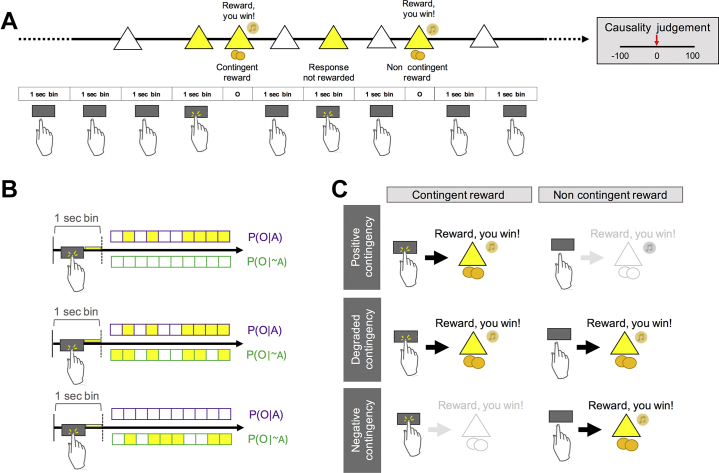
Experimental paradigm. (A) Subjects had to complete an experimental session of 12 blocks of 2 minutes each. At the end of each block, subjects had to judge to what extent pressing the space bar caused the occurrence of the reward, on a scale from −100 (pressing the space bar always prevented reward) to 100 (pressing the space bar always caused reward). During the experimental session, the participant was presented with a white triangle and could decide whether to press the space bar or not. Rewards were delivered contingently on pressing of the space bar or noncontingently in the absence of a response. In addition, a running total of the amount of money earned within a block was continuously displayed in the upper corner of the screen (not shown in figure). In cases where the participant was not pressing the space bar for multiple (hidden) 1-second bins in a row, the white triangle was continuously displayed on the screen, unless a nonresponse contingent reward occurred. In those cases, a reward was displayed on the screen noncontingently. (B) Each block was divided into 120 unsignaled time periods (bins) of 1 second. When a response occurred within each bin, the triangle turned yellow until the bin ended. If a response was recorded during the bin, a contingent reward was delivered at the end of that bin according to the applicable probability of outcome delivery given a response [P(O|A)]. If no response occurred during the bin, a noncontingent reward was delivered according to the applicable probability of outcome delivery given the absence of a response [P(O|∼A)]. (C) By varying P(O|A) and P(O|∼A), different levels of contingencies were achieved so that each experimental session included positive, degraded, and negative contingency blocks. O, outcome; P(O|A), probability of outcome given an action; P(O|∼A), probability of outcome given the absence of an action.